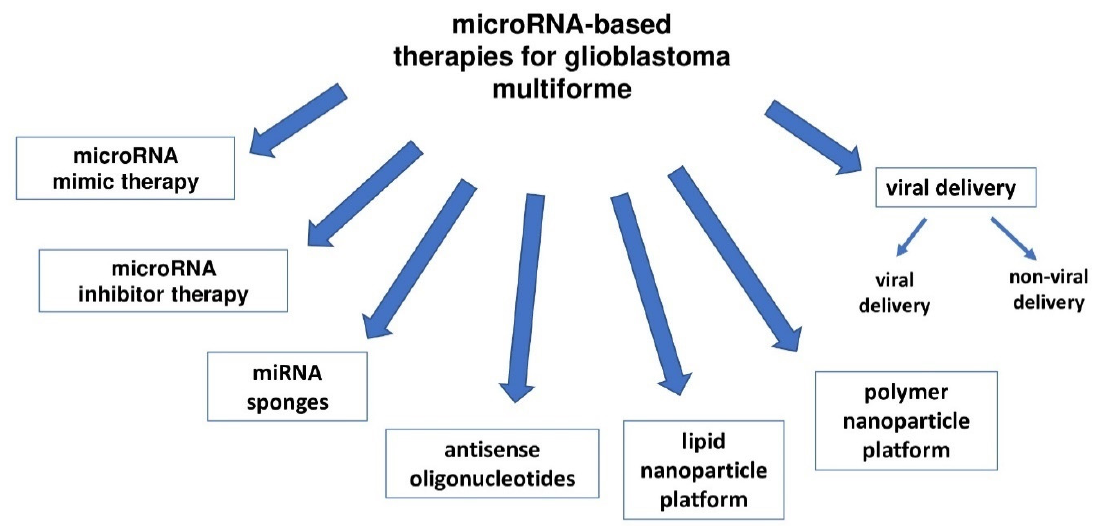
Figure 3. The use of miRNA in therapeutic strategies for glioma.